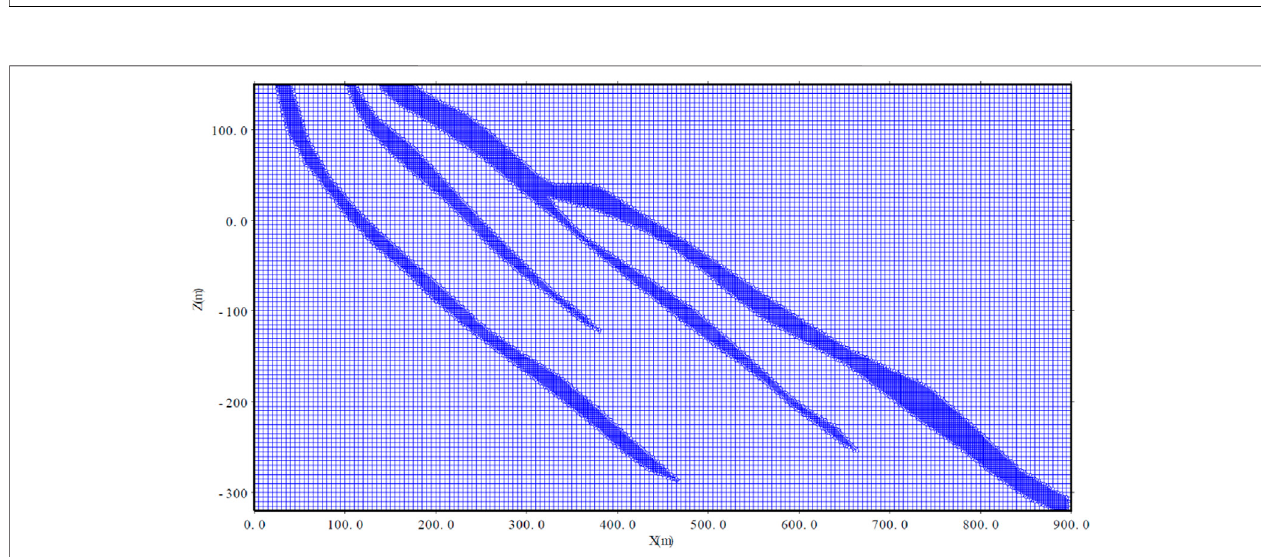
FIGURE 8 | The 2D model discretization (the mesh around the fault has been re fi ned, as shown in the dark blue area).